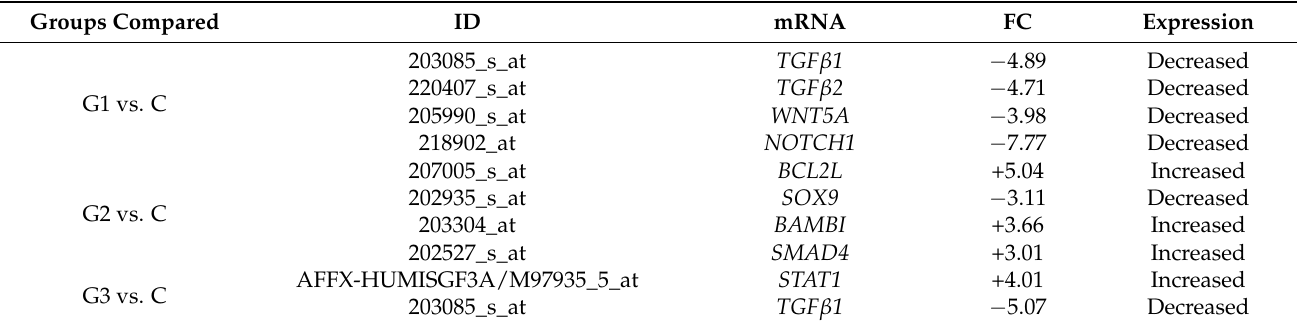
Table 5. Expression profile of mRNAs related to Epithelial–Mesenchymal Transition (EMT) differentiating endometrial cancer from the control ( − 3.0 < FC > 3.0; p < 0.05). Groups